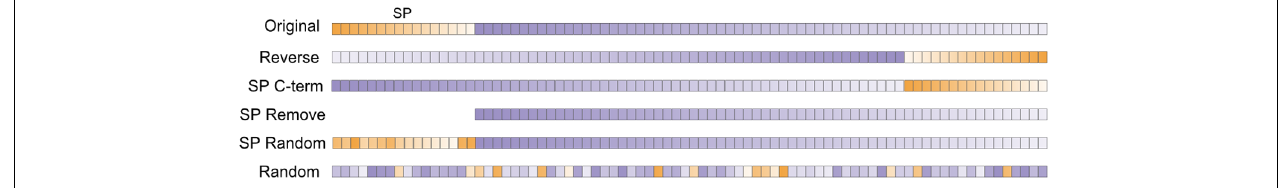
FIGURE 2 | After the SP region (orange) was identified using SignalP 4.1 for positive data or a fixed length of 30 amino acids for negative, five modifications were made to each original sequence in a dataset. Reverse inverted the amino acid order of the entire sequence; SP C-term placed the SP at the C-terminus, leaving the sequence length unchanged; SP Remove excluded the SP region and shortened the sequence length. SP Random and Random involved random shuffling of the SP region and the entire coding sequence, respectively. The sequences were then submitted to SecretomeP. Orange, SP region; Purple, mature protein